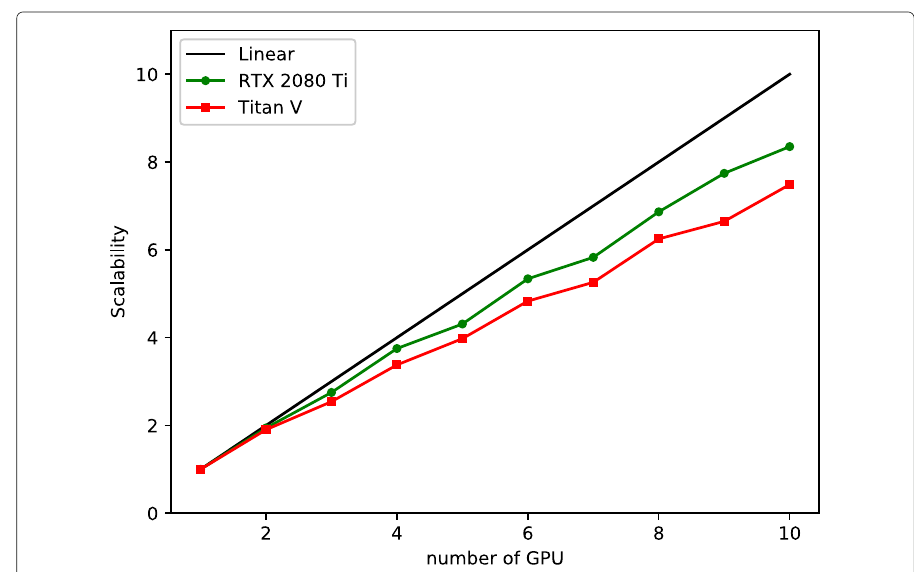
Fig. 15 Strong scaling result of different GPU. Both GPUs’ scalabilities deviate from linear result, but the efficiencies are all larger than 75% when 10 GPUs are utilized. The drops of scalability come from the fact that when grid size decreases, the speedup drops too, see Fig. 13. Scalability of Titan V drops faster than RTX 2080 Ti’s, because the speedup of Titan V drops faster than RTX 2080 Ti’s when the grid size decreases